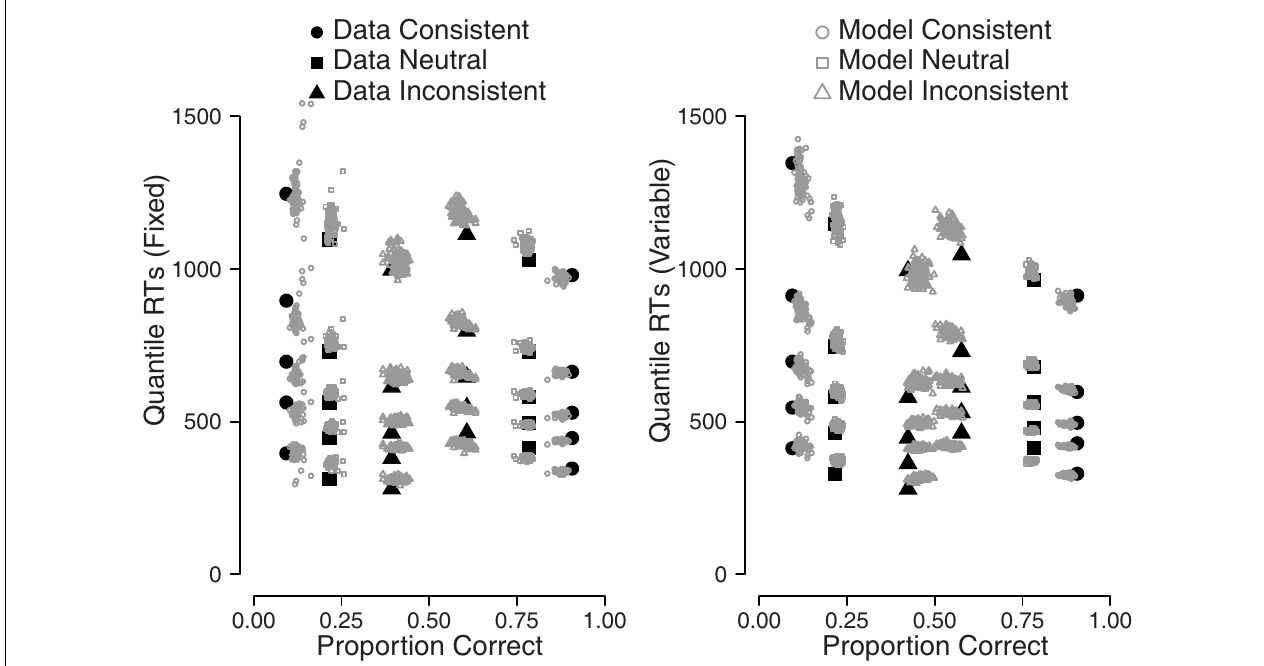
FIGURE 9 | Model predictives indicate that the parameter estimates of DMAT describe the data well. Filled symbols: empirical data. Open symbols: bootstrapped synthetic data, based on the model parameter estimates.